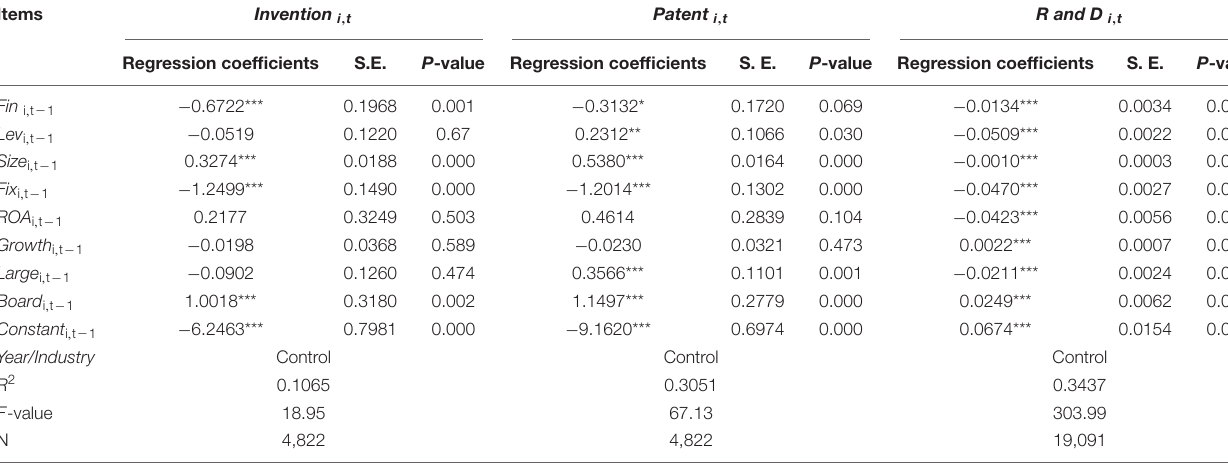
TABLE 7 | Test of endogenous problems.